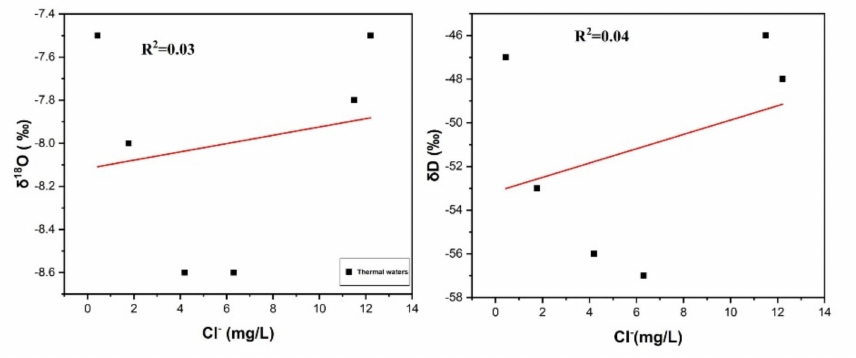
Figure 5. Chlorine vs. δ 18 O and δ D graph of geothermal